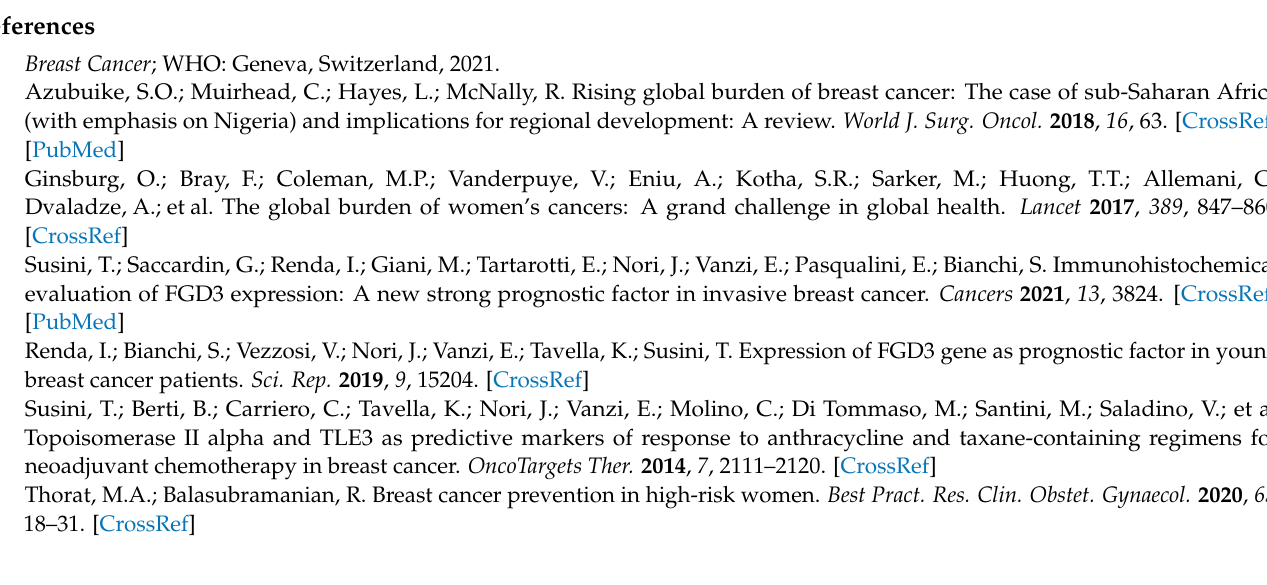
Figure S2: LSMs transcription levels in different stages of breast cancer (UALCAN database), Figure S3: LSMs DNA methylation level in patients with breast cancer versus healthy controls, Figure S4: Rep- resentative immunohistochemistry images of LSM2, LSM3, LSM4, LSM7, LSM14b in breast cancer patients, Figure S5: LSM4 expression between normal and tumor groups ( n = 1222 patients from GDC database), Figure S6: Expression profiles of LSM4 in DEGs methods, Figure S7: DNA methyla- tion clustered expression of LSM4 (TCGA dataset), Figure S8: Functional enrichment analysis with gene ontology (GO) terms and KEGG of differentially expressed genes (DEGs); Table S1: The basic characteristic of LSM4 gene on Oncomine database, Table S2: Statistical values of LSM family genes expression base on individual cancer stage, Table S3: Prognosis value of CpGs in LSM4 (MethSurv database), Table S4: Gene sets enriched in high expression LSM4, Table S5: Pathway analysis of LSM4-coexpressed genes from public breast cancer databases using the MetaCore